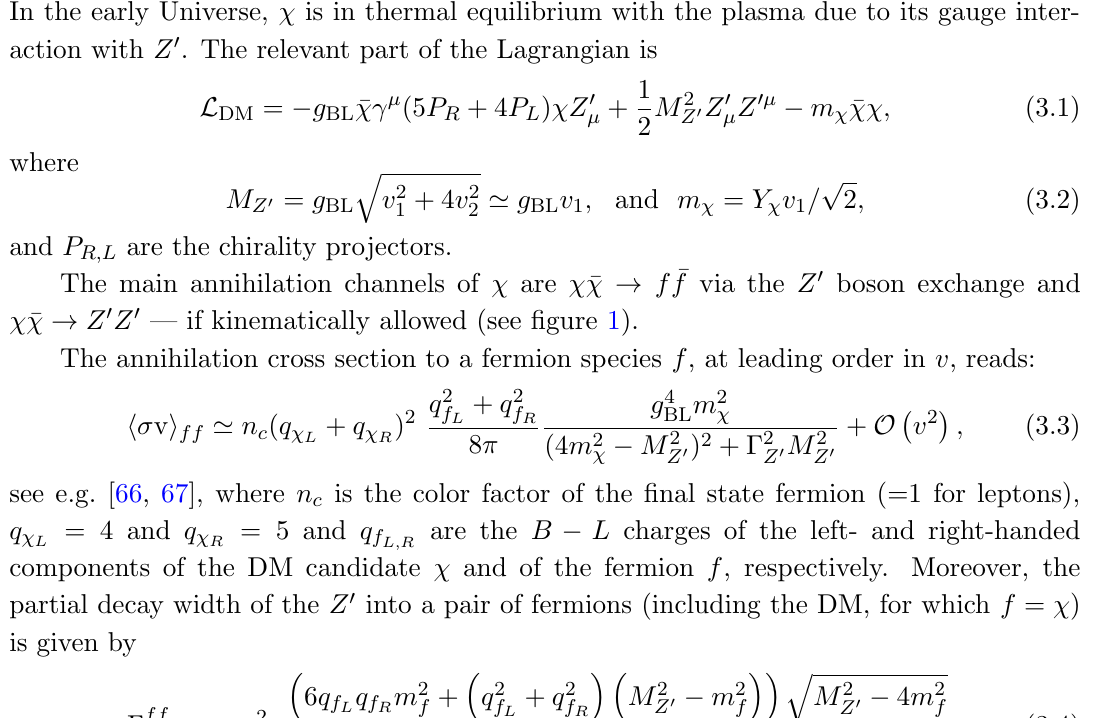
Z 0 Z 0 . The (cid:31) (cid:22) (cid:31) ! ’ 1 Z 0 Z 0 is velocity suppressed this ! !